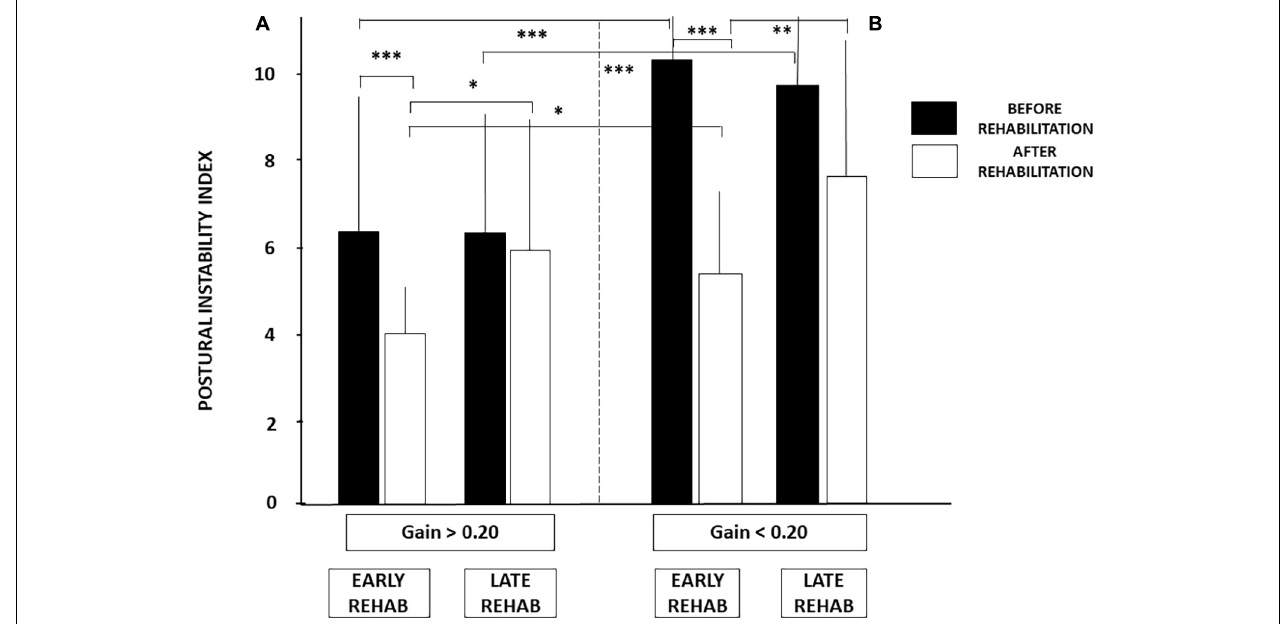
FIGURE 5 | (A,B) Effect of both early rehabilitation and degree of pre-rehabilitation vestibular hypofunction on dynamic balance recovery in the patients with UVH; stability index. Comparison of the recovery profiles in the four sub-groups of patients with UVH tested in dynamic posturography (unstable platform) with eyes closed. Mean postural instability index (PII, ± SD) calculated with the wavelet analysis is shown for both sub-groups with pre-rehabilitation aVOR gain above (A) and below (B) 0.20. PII scores are shown before rehabilitation (filled histograms) and after rehabilitation (open histograms). Better recovery depends on both early rehabilitation and degree of vestibular hypofunction. Significant differences are indicated by asterisks. ∗ p < 0.05; ∗∗ p < 0.01; ∗∗∗ p <